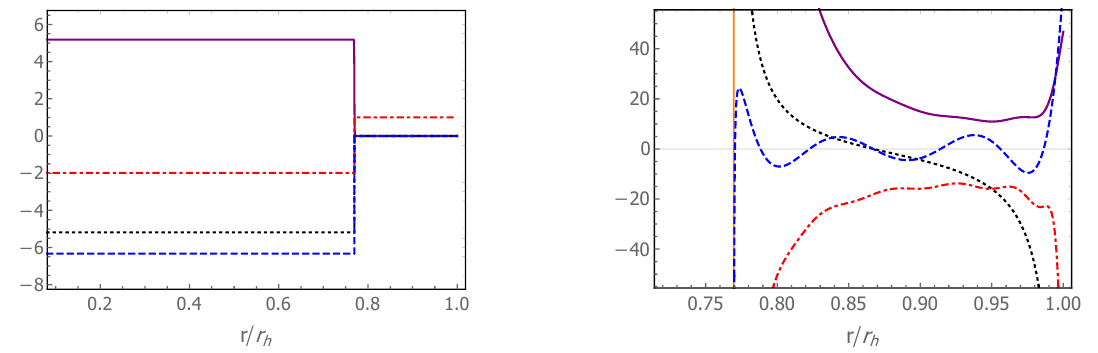
Figure 5 . The interior configuration of charged helical black hole with α b = 0 . 01 , T/µ = 0 . 1 , k/µ = 7 . Left : the plots of 10 − 27 rf 0 /f (purple), 10 − 27 rg 0 /g (black), rh 0 /h (red) and 10 − 12 rα 0 (blue) as functions of r/r h . Note that the corners of these plots are smooth. Right : the plots in the region between the event horizon and the would-be inner horizon r/r h = 0 . 7696 (the orange vertical line) of rf 0 / (10 α 2 f ) (purple), rg 0 /g (black), ( rh 0 /h − 1) / (4 α 2 ) (red) and rα 0 / (4 α h ) (blue) h h where α h is the horizon value of α .